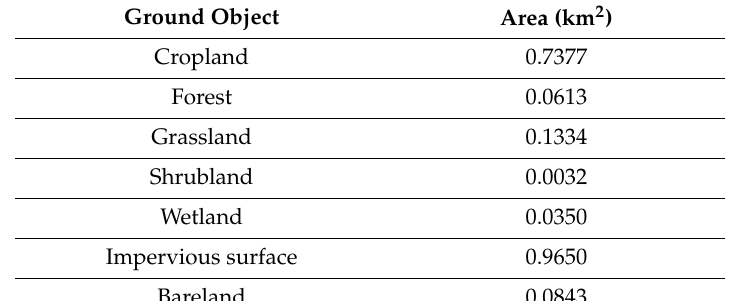
Table 1. Statistics of flooded area.